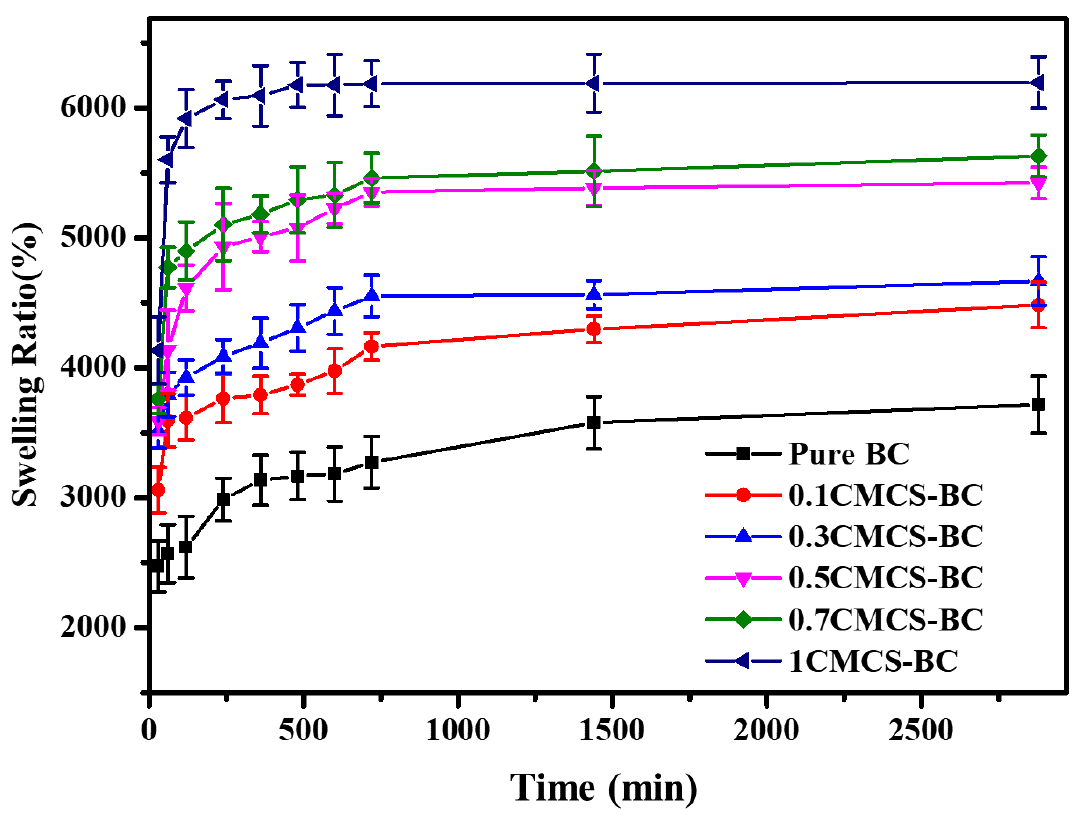
Figure 5. Swelling properties of CMCS–BC hydrogels.